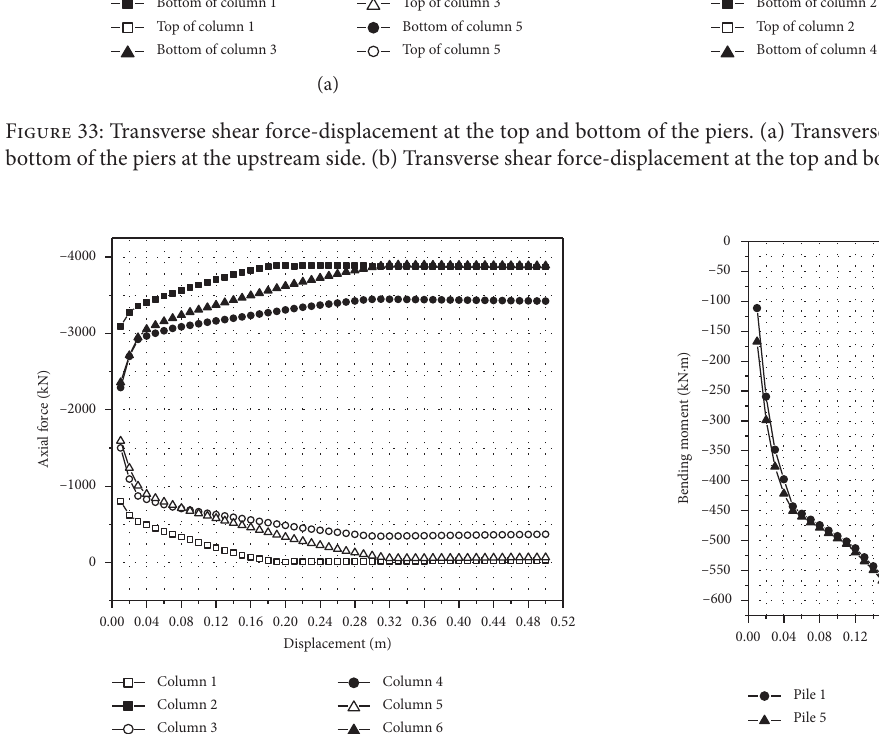
Figure 34: Axial force-displacement at the bottom of the bridge pier.